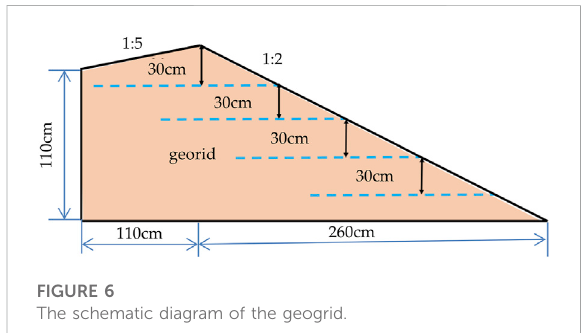
FIGURE 6 The schematic diagram of the